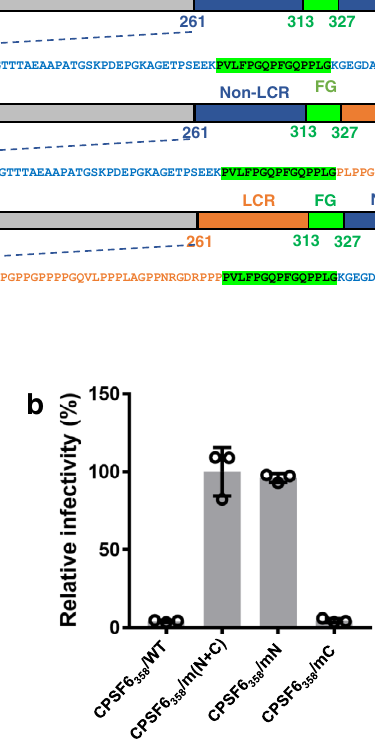
C-terminalLCRwasreplacedwithnon-LCRsequencesfromNEURM 97-179 . b Relative infectivity of VSV-G pseudotyped HIV-1 in the Hela cells stably overexpressing proteinsshownin a .InfectivitywasnormalizedtoCPSF6 358 /m(N+C).Theaveraged data (+/ − SD) from three independent experiments are shown. Source data are provided as a Source Data fi le. LCR low complexity